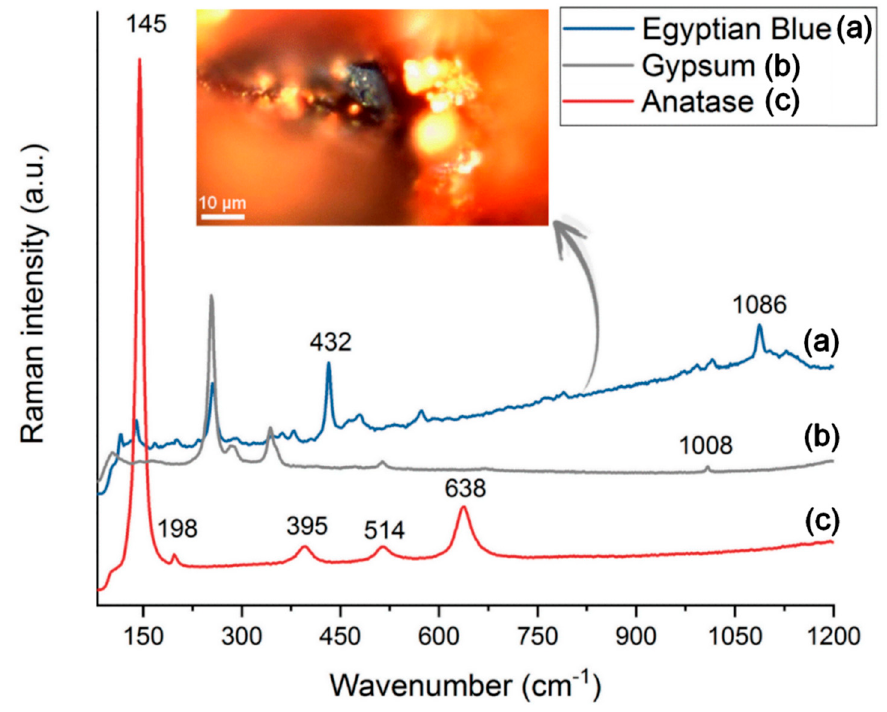
Figure 7. Raman spectra of the impurities found in the raw cinnabar pigment excavated in Pompeii (Egyptian Blue ( a ), gypsum ( b ), anatase ( c )) and micrograph of the Egyptian Blue grain.